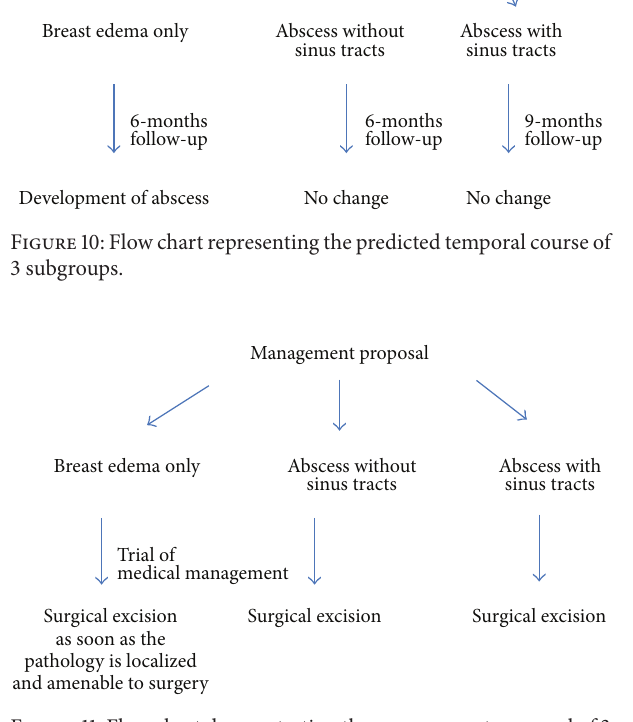
Figure 11: Flow chart demonstrating the management proposal of 3